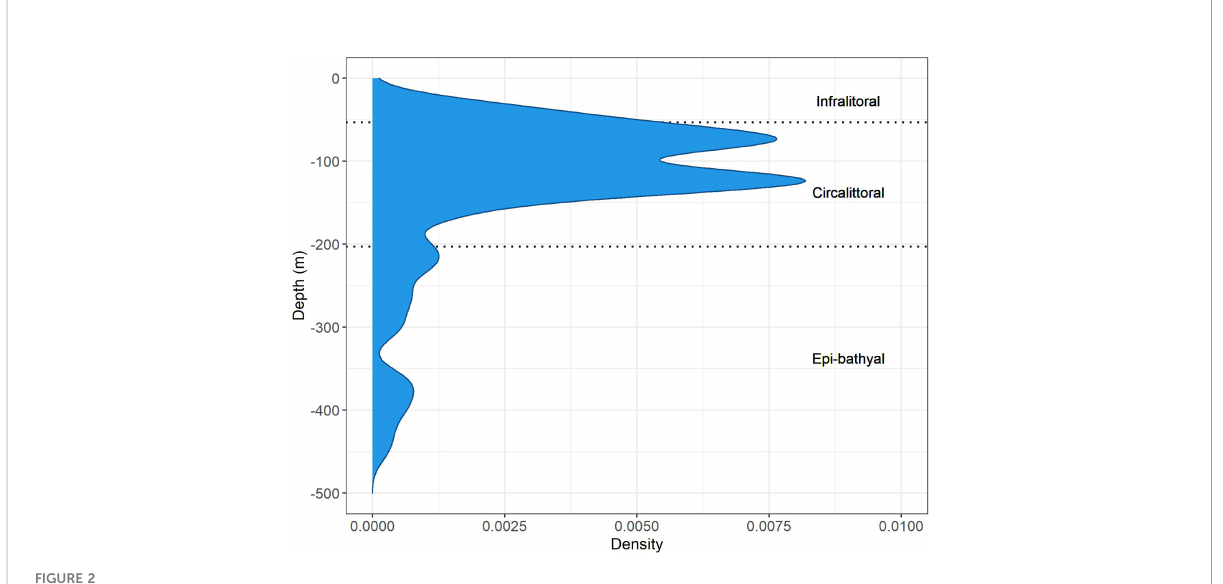
FIGURE 2 Bathymetric distribution of P. regalis in